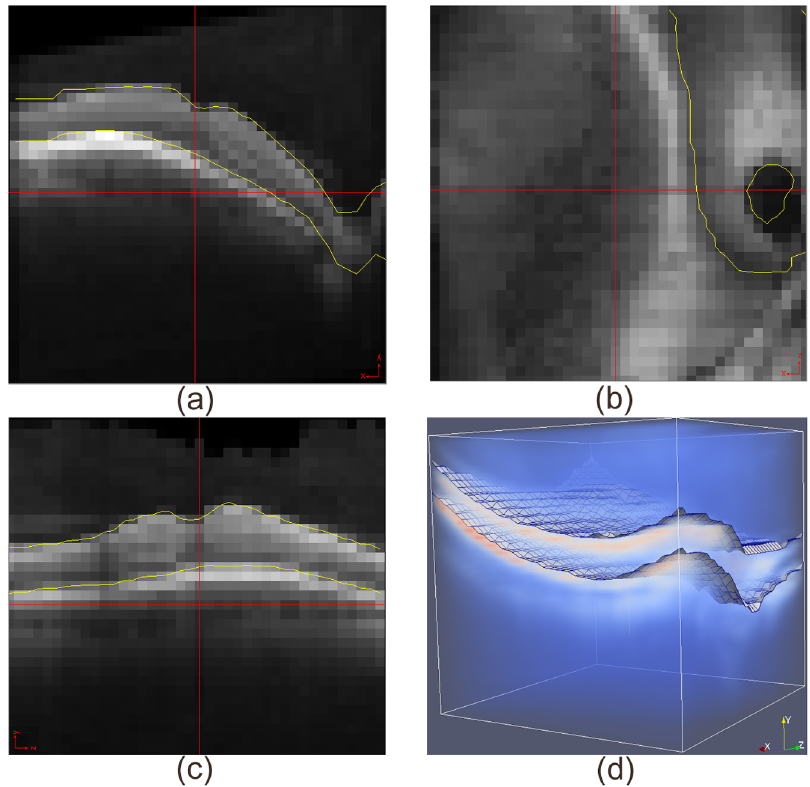
Figure 14. Segmentation of OCT volume with non-Euclidean graph search. (a) Cross section of one B-scan; (b) Top view; (c) Cross section perpendicular to B-scan; (d) 3D volume rendering.